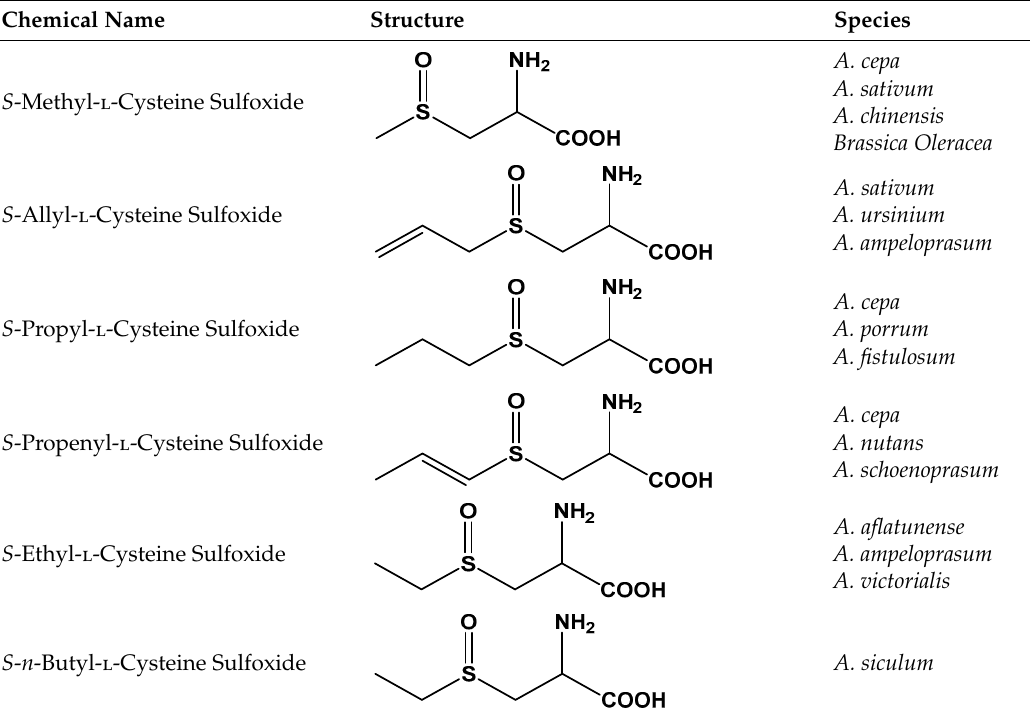
Table 1. Allium and brassica S -Alk(en)yl- L -cysteine sulfoxides (adapted from [2]).